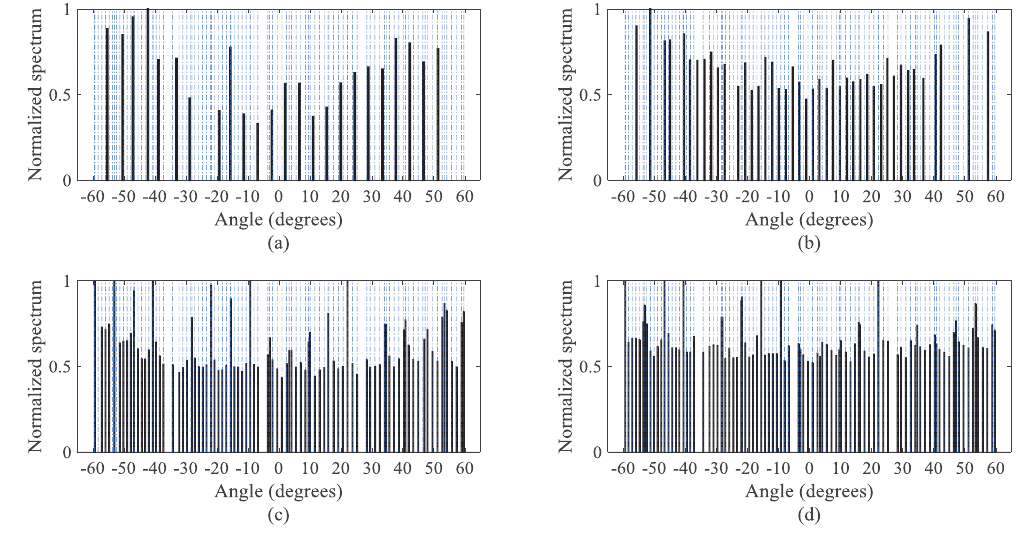
Figure 8. Spatial spectra of the non-uniformly distributed signals detected by the four virtual configurations ( Q = 101 and SNR = 10 dB): ( a ) the ULA with the NC MUSIC used; ( b ) the ULA with the VNCM used; ( c ) the CAMpS with the VNCM used; and ( d ) the DsCAMpS with the VNCM